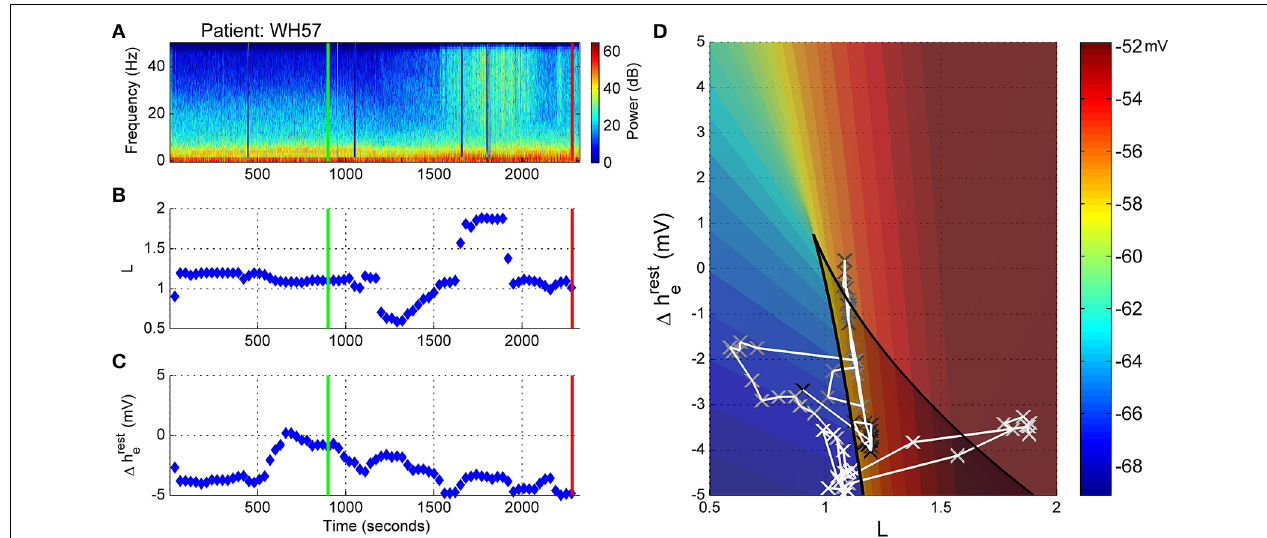
FIGURE 11 | Patient WH57, Sleep Manifold. (A) Spectrogram as in Figure 10 . (B) Excitatory connection strength (L-parameter) over period of observation. (C) Change in resting membrane impedance ( (cid:2) h rest e ) over period of observation. (D) Resultant positioning on the